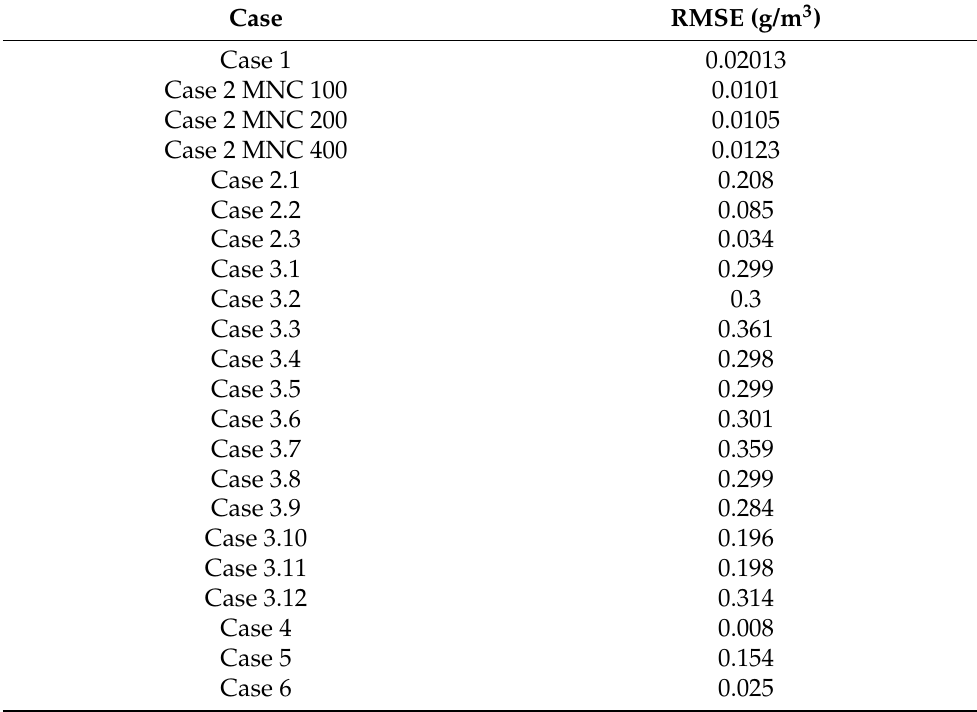
Table 4. Root mean square error of the reconstructed boundary